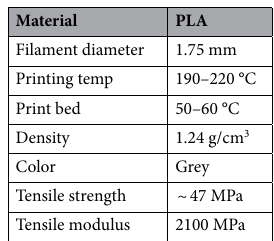
Table 1. PLA material